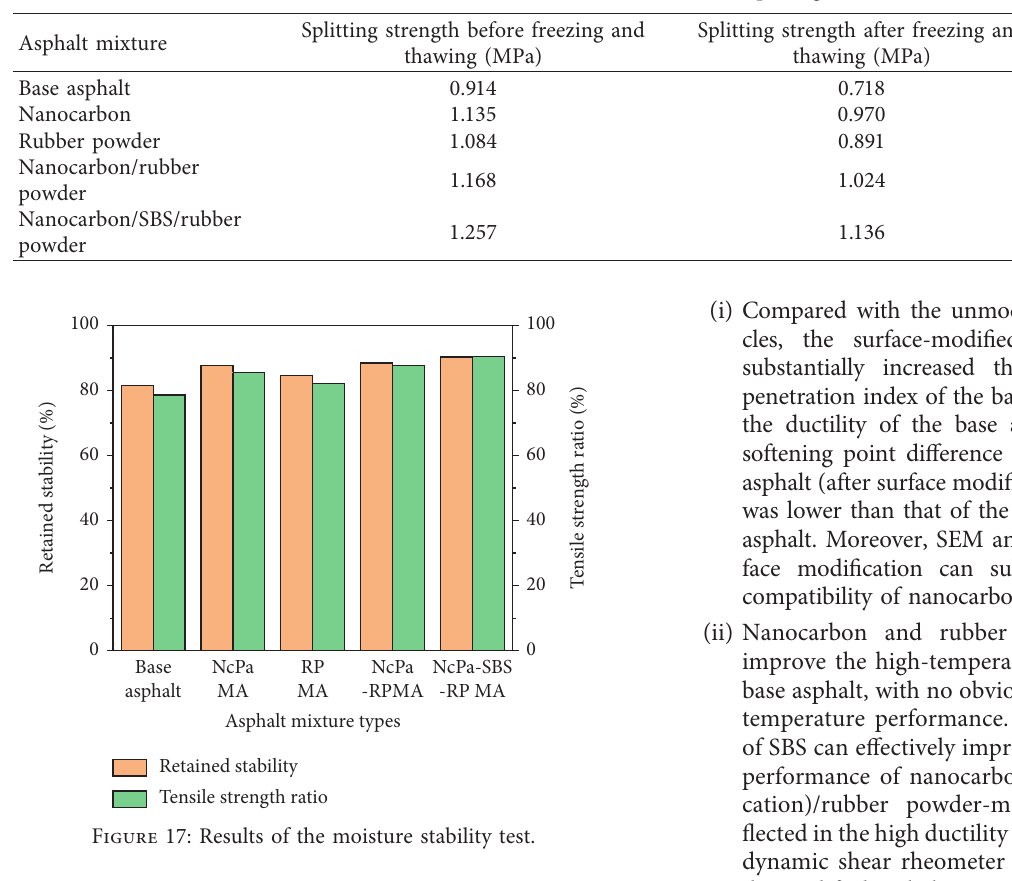
Table 11: Results of the freeze-thaw splitting test.